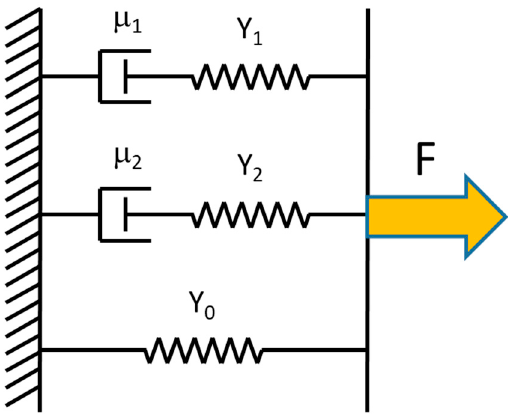
Figure 4 . Kelvin model consisting of an elastic spring in parallel with two elements consisting of a dashpot and an elastic spring in series. This model was used to fit the incremental stress–strain curves.